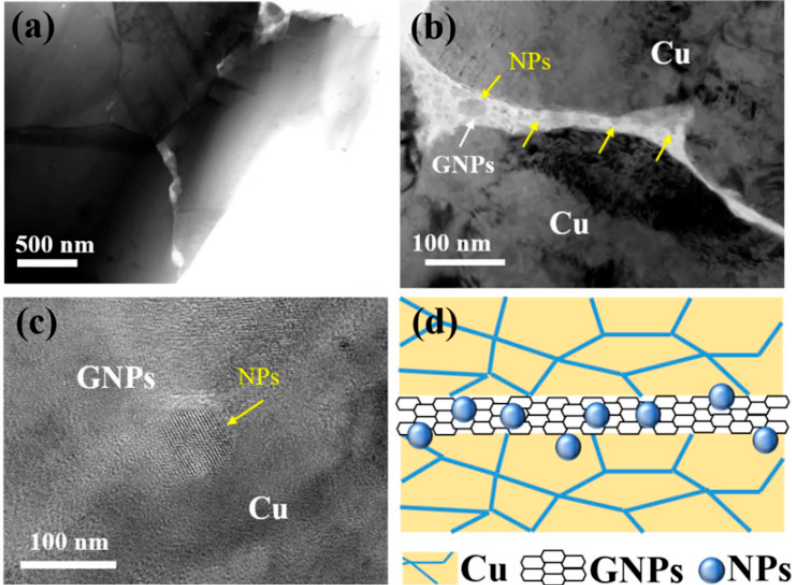
Figure 1. TEM and HRTEM images of existing form and dispersion of nanoparticles: ( a ) TEM of existing morphology of GNPs within the matrix; ( b ) Enlarged TEM images of ( a ); ( c ) HRTEM images of existing form of nanoparticles; ( d ) Schematic illustration of dispersion of nanoparticles [16]. Reprinted/adapted with permission from Ref. [16]. Copyright year 2020,